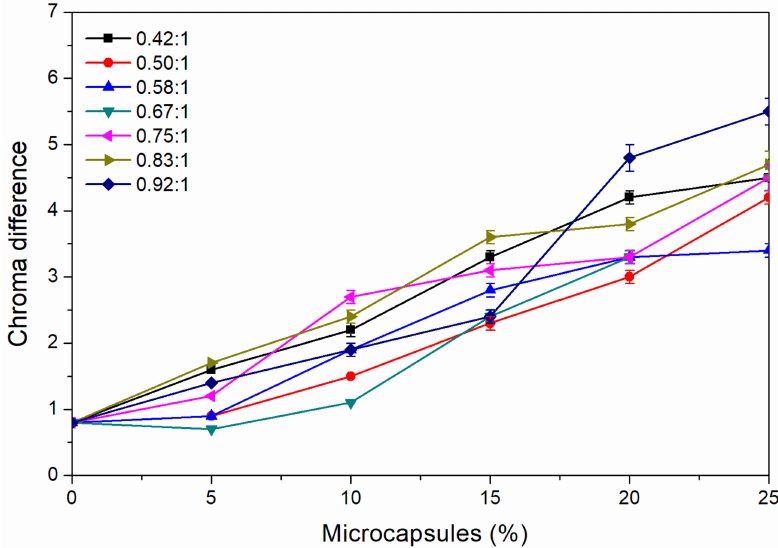
Figure 7. E ff ect of the concentration of microcapsules with a di ff erent core–wall ratio on the chroma di ff erence of waterborne primer